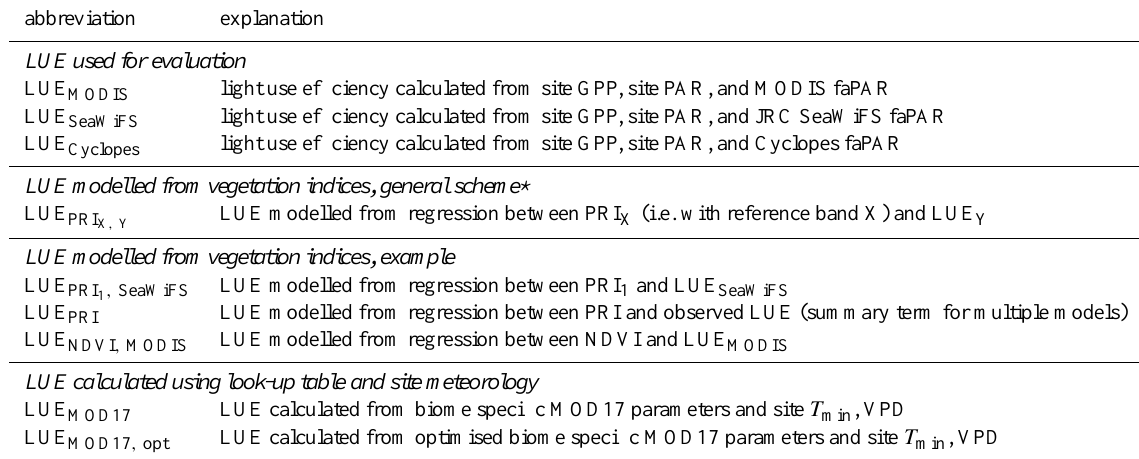
Table 3. Overview of abbreviations used for “in-situ” light use efficiency and for LUE modelled from vegetation indices (The models denoted with ∗ were established for each site (for all MODIS viewing angles and also specifically for viewing angles < 10 ◦ ) as well as for all evergreen sites combined and the two evergreen oak sites